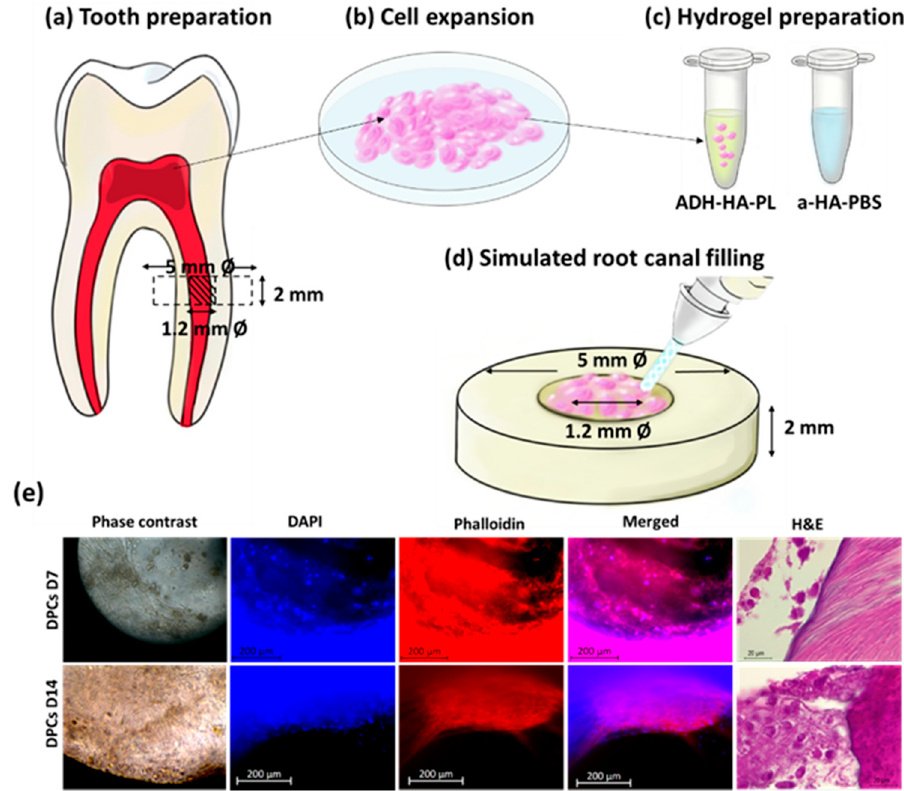
Figure 4. Hydrogels’ ability to deliver DPCs. ( a ) Schematic representative of the preparation of a tooth slice organ for cell culture. A human sound tooth was used to get DPCs. ( b ) DPCs cells isolated from the human sound tooth were cultured to test the hydrogel’s ability to deliver stem cells and ( c ) 8 × 106 of cells per mL were resuspended in ADH-HA-PL hydrogel precursor solution. ( d ) Using a double-barrel syringe, the hydrogels’ precursors were mixed and injected into preconditioned dentin discs of 5 mm diameter and 2 mm heigh with a hole standardized at 1.2 mm diameter corresponding to its root canal were used as tooth slice organ TSO. The TSOs were cultured to test the hydrogels’ ability to deliver dental stem cells. DPCs encapsulated in HAPL ( e ) TSO containing DPCs after 7 days and 14 days in culture by phase-contrast microscopy (10×), fluorescence microscopy (DAPI-Phalloidin staining; 20×) and representative histological section (H&E staining; 100×). Indentation test.